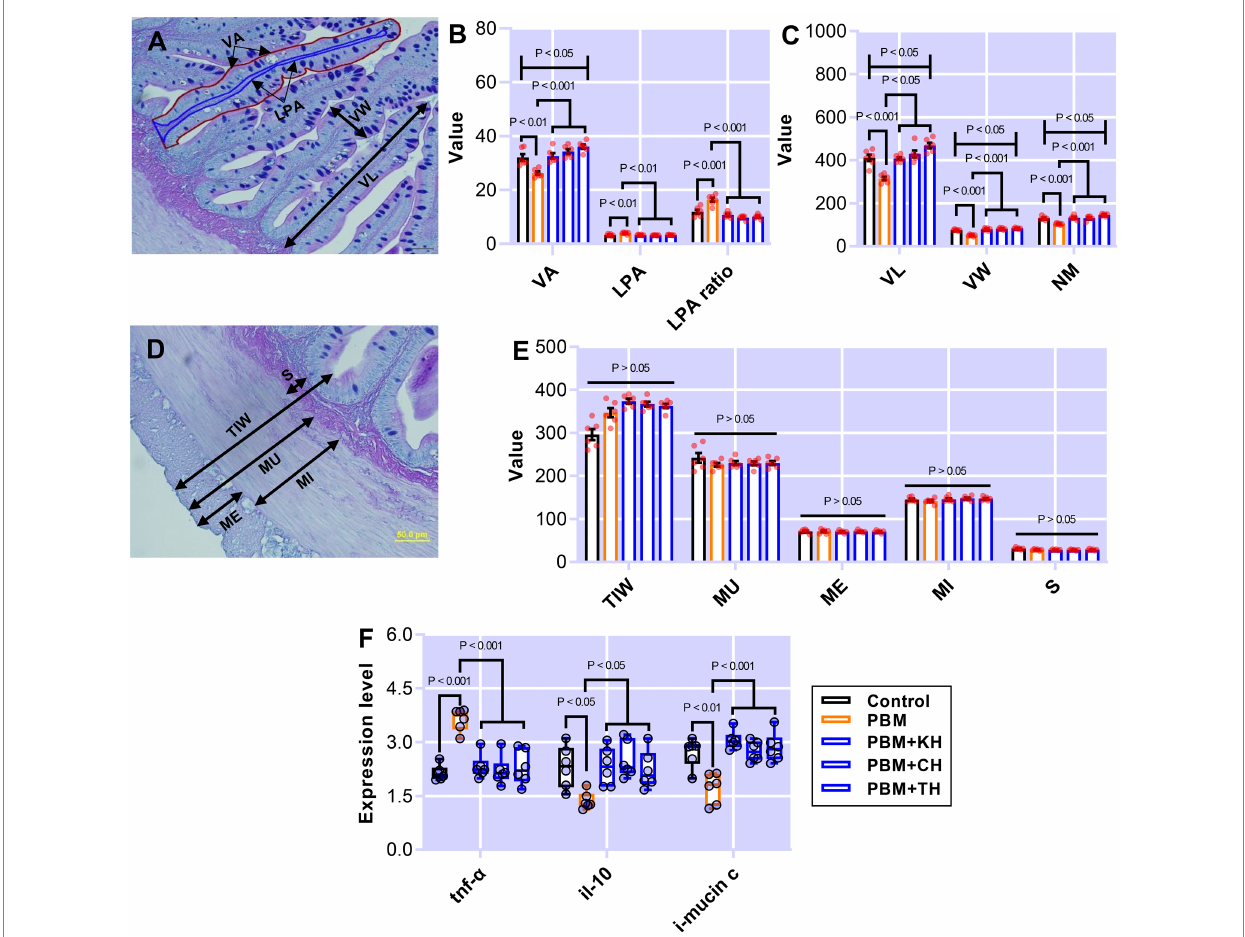
FIGURE 1 The representative histological micrograph of the intestine showing measurements (A,D) ; the comparison of quantitative measurements of the intestine (B,C,E) and fold change in the expression of pro- and anti-inflammatory cytokines and mucin production relevant gene (F) of barramundi fed FM-based control, PBM alone, or supplemented with various FPHs supplemented diets over a period of 42 days. VA, villus area; LPA, lamina propria area; VL, villus length; VW, villus width; NM, neutral mucin; TIW, total intestinal wall; MU, muscularis thickness; ME, muscle interna; MI, muscle ineterna; S, submucosa, tnf- α , tumor necrosis factor; il-10 , interleukin 10, and i-mucin c , integument mucin